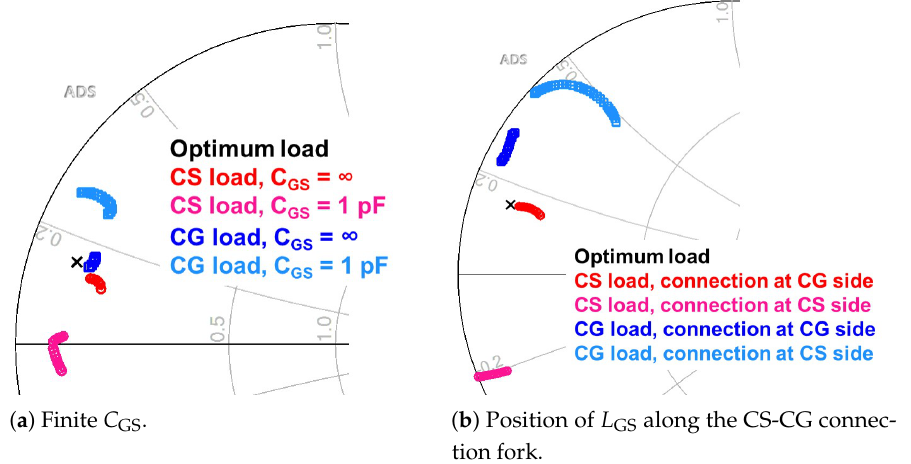
Figure 16. Effect of on matching of CL non-idealities. The gate capacitances are implemented with lumped, low-capacitance-density MIM capacitors. The two shunt inductances are replaced by equivalent transmission lines, while squared spiral inductors are used for the gate-source inductances. Finally, self-bias resistances are replaced with GaN resistors ( ∼ 400 Ω / (cid:3) ). The value of the final optimized components is reported in Table